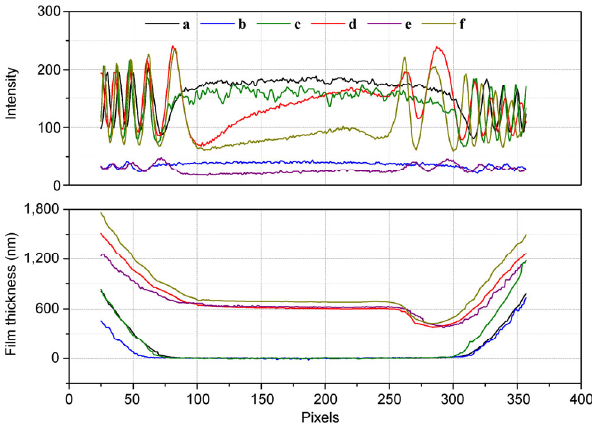
Fig. 9 Optical intensities of the images in Fig. 8 at the centerline along the motion direction and film profiles corresponding to each image.